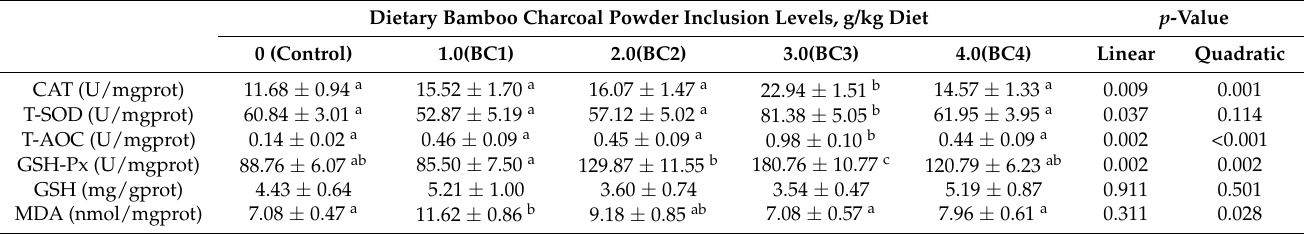
Table 6. Hepatic antioxidant enzymes of blunt snout bream fed with the experimental diets 1 . Dietary Bamboo Charcoal Powder Inclusion Levels, g/kg Diet p